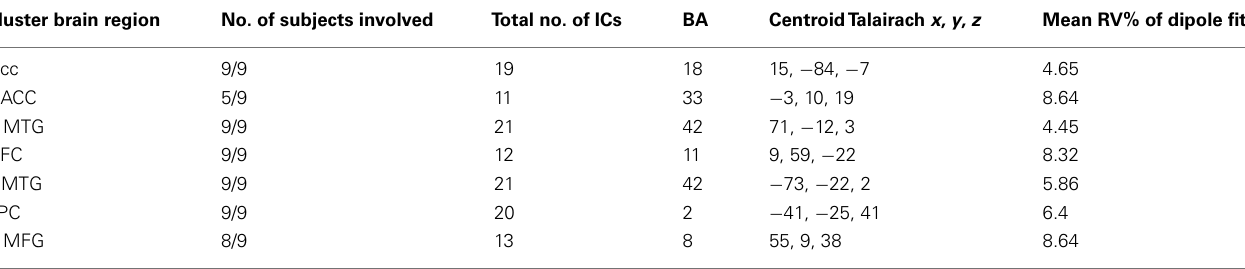
Table 2 | Cluster properties Experiment